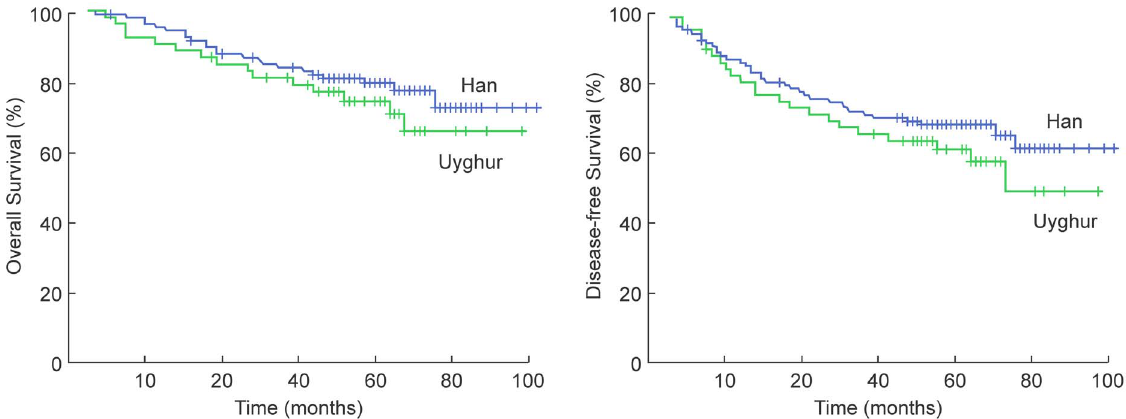
Figure 1. Survival curves for Han and Uyghur patients who received intensity-modulated radiation therapy for nasopharyngeal